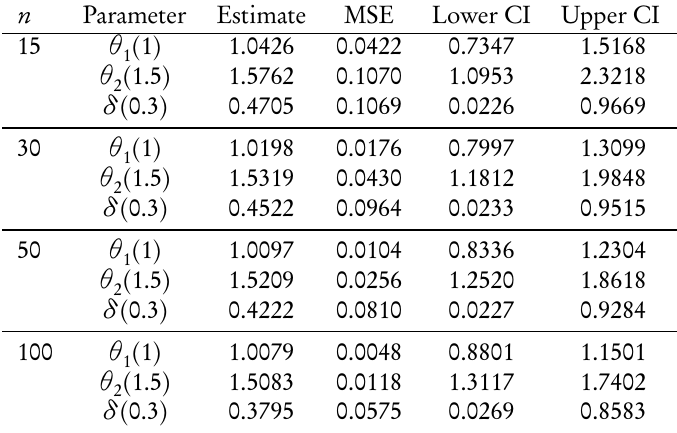
Simulation study of the parameters of BXG distribution (Case 2 - MLE).